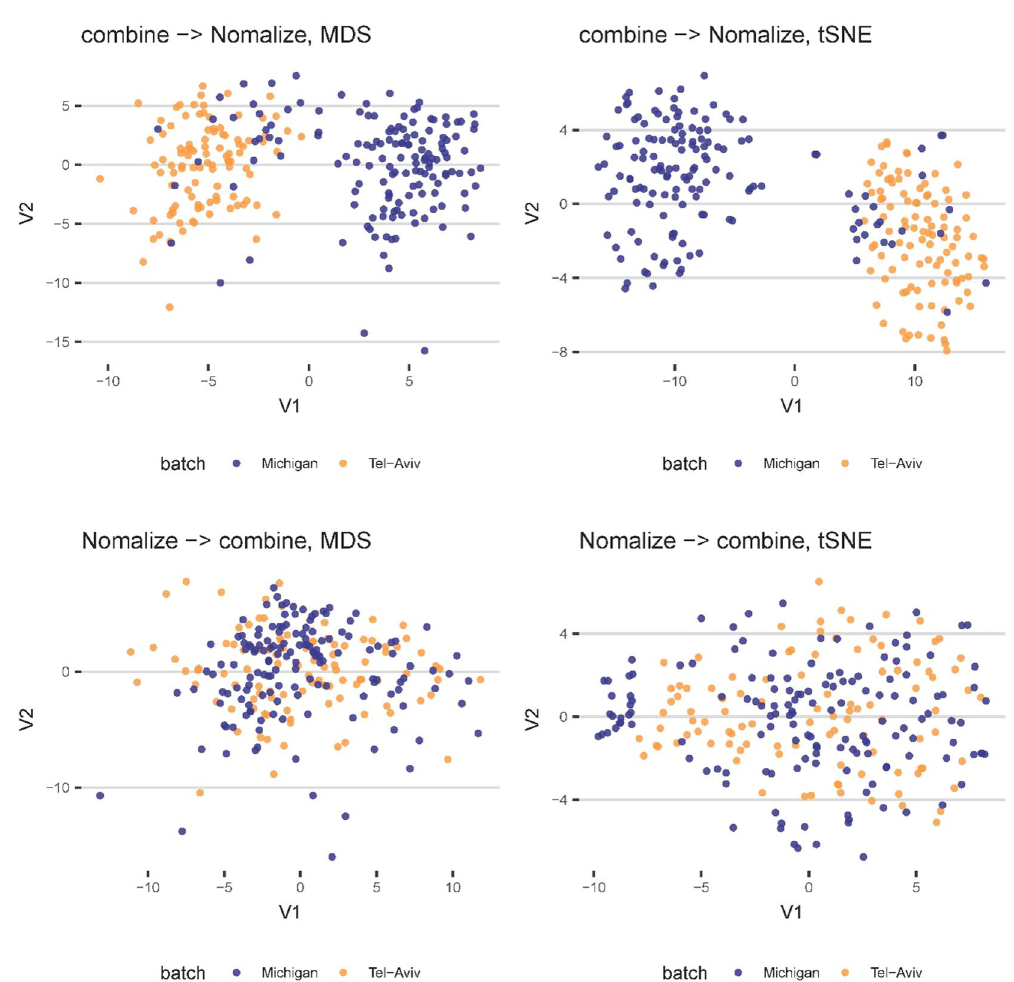
Figure 7. Visualization of batch effects of the aggregated data using different data aggregation strategies (normalize the two data sets separately vs. normalize the combined data) using two alternative dimensionality reduction methods - MDS (left) and tSNE